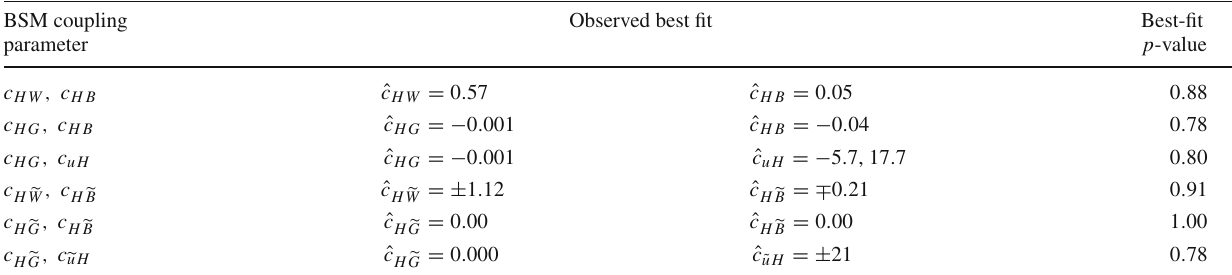
Table 10 The best-fit values and the corresponding deviation from the SM prediction obtained from the two-dimensional likelihood scans of the CP-odd BSM coupling parameters performed with 139 fb − 1 of data